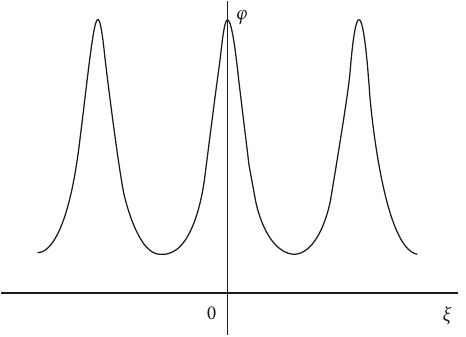
Figure 3: The periodic wave of equation (1) for 1 < c < ( 7/5 ) .